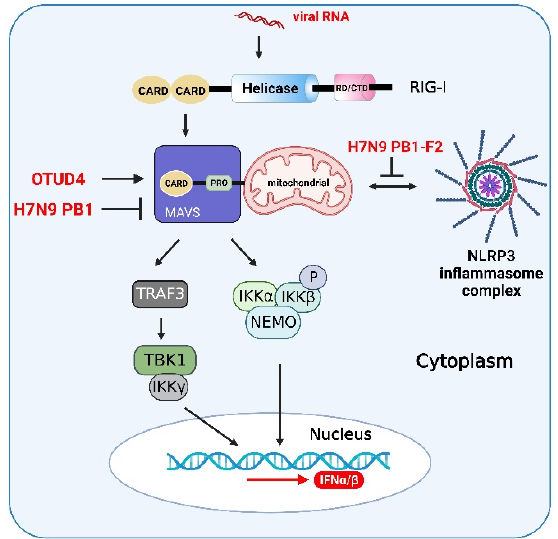
Figure 6. Viral proteins and host proteins in the crosstalk of IFN, NF- κ B, and inflammasome signaling pathways. After activation of RIG-I-mediated signaling pathway induced by RNA virus infections, ovarian tumor family deubiquitinase 4 (OTUD4) targets MAVS to remove the Lys (K)48-linked polyubiquitin chains, thereby maintaining MAVS stability and promoting innate antiviral signaling. The PB1 protein of the H7N9 virus promotes RNF5 to catalyze the K27-linked polyubiquitination of MAVS at K362 and K461 to inhibit host type I interferon production. The crosstalk between MAVS and NLRP3 and the PB1-F2 protein selectively antagonize RNA-induced NLRP3 inflammasome activation by inhibiting MAVS-NLRP3 crosstalk. The figure was created using the online software “Biorender” (https://app.biorender.com/ The updated figure was created on 30 November 2022).